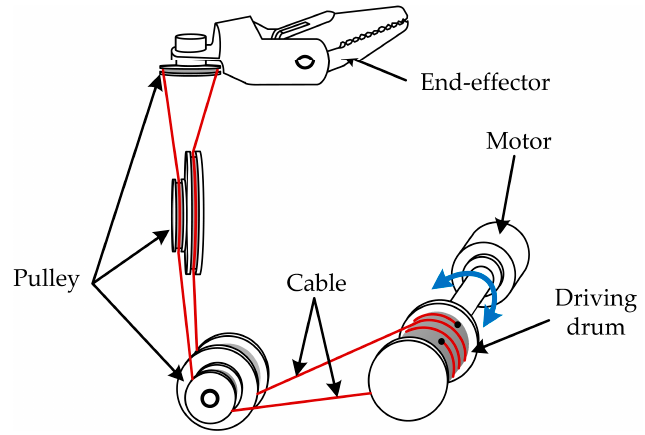
Figure 4. The cable-pulley system studied in this paper.